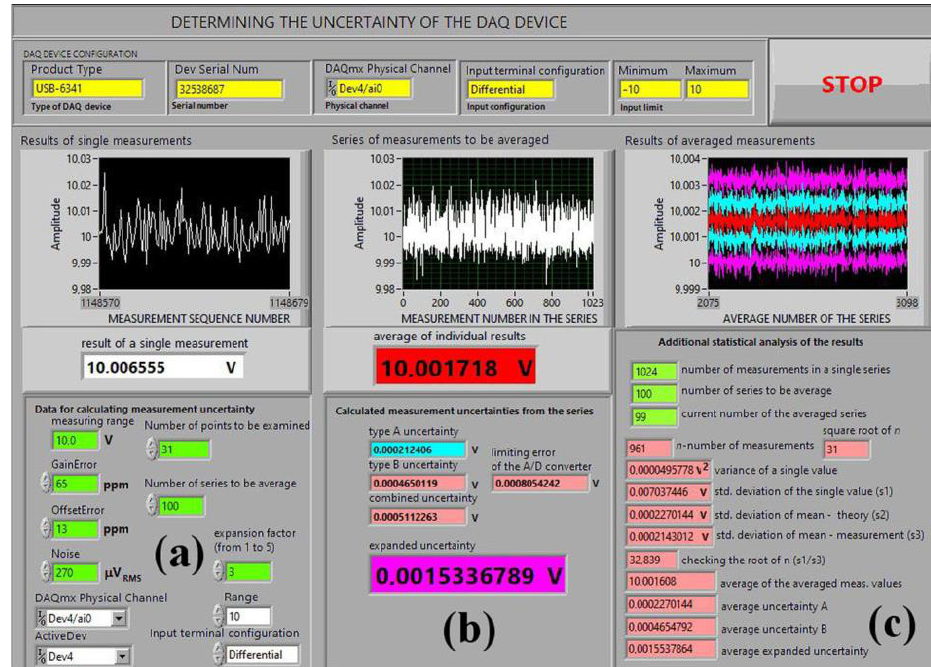
Figure 7. Left panel part of the LabVIEW application: ( a ) data configuring measurements and uncertainty calculations; ( b ) results of measurements and calculations in a single series of measurements; ( c ) results of calculations of statistical parameters for repeatedly repeated series of measurements.